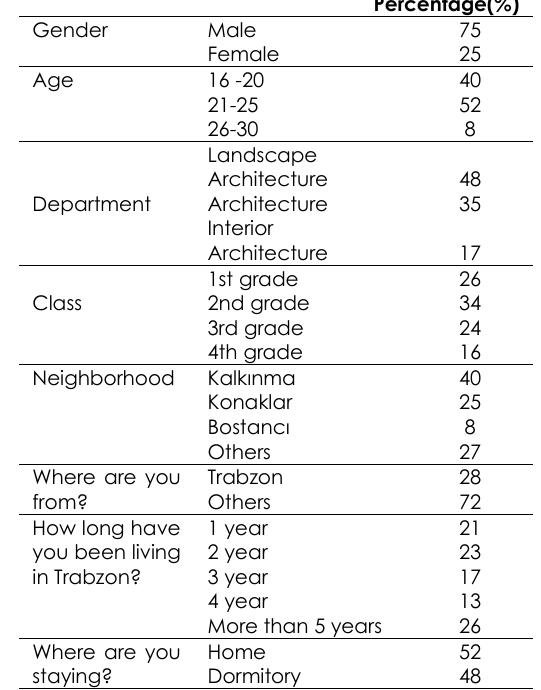
Table 1. Percentage (%) distribution of demographic characteristics of participants.